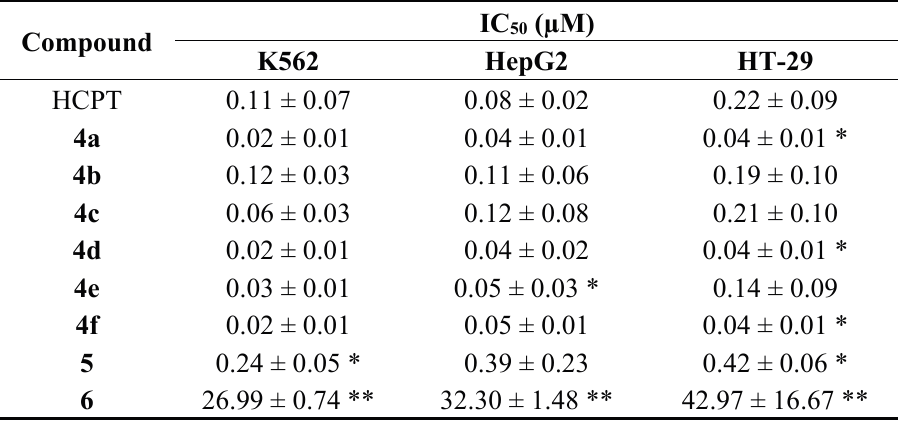
Table 1. Antiproliferative activity of the conjugates in vitro.